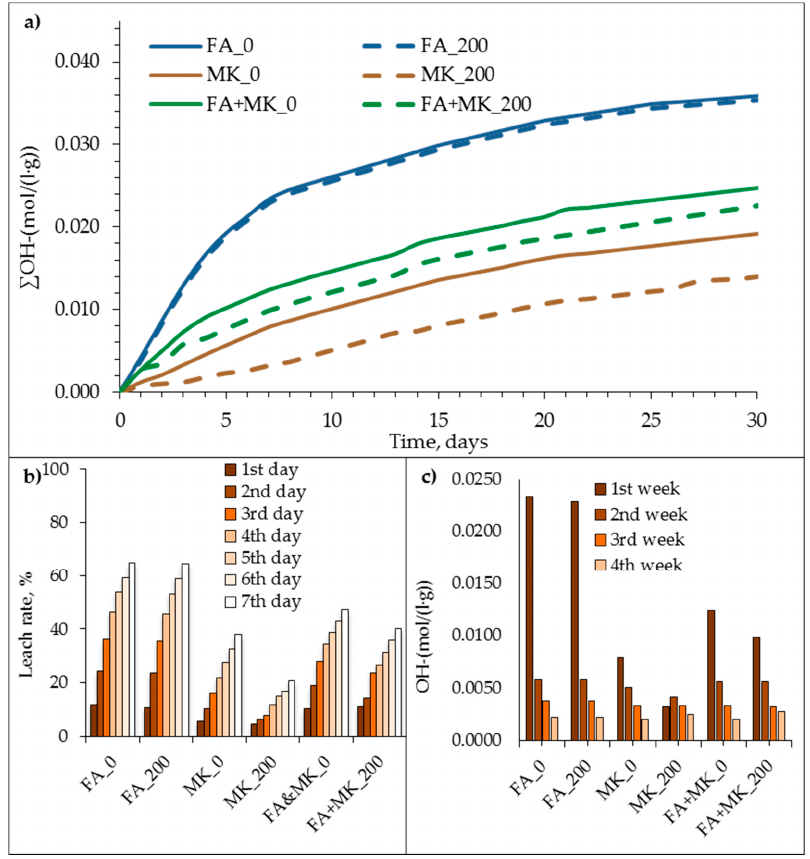
Figure 11. ( a ) The cumulative leaching rate of OH − ions; ( b ) OH − ions leached in the first testing